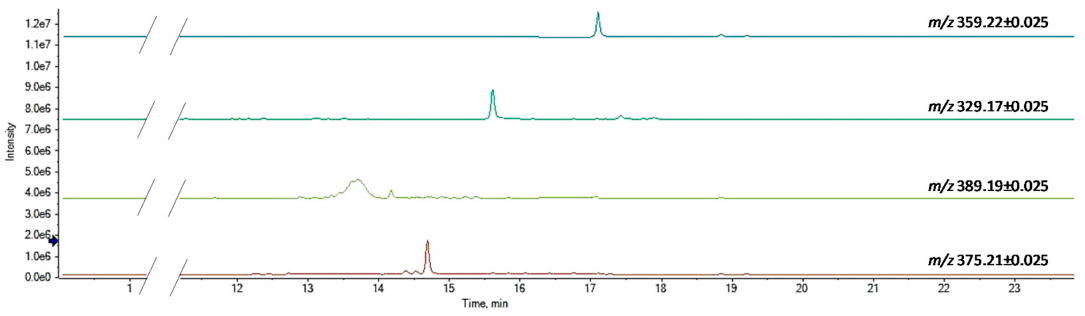
Figure 3. XICs of minor phytocannabinoid constituents.